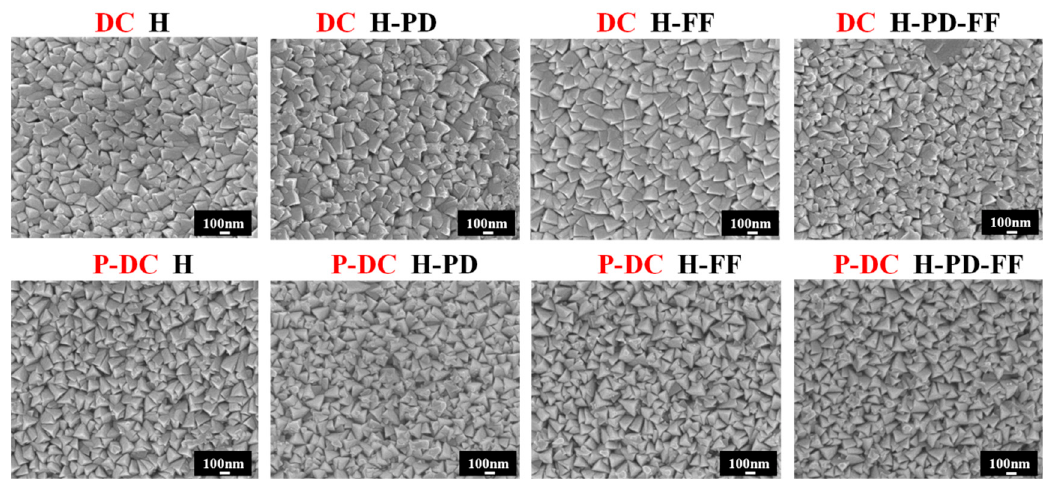
Figure 7. Top-surface SEM images of TiN coatings created using various HiPIMS operating modes under DC or P-DC bias.